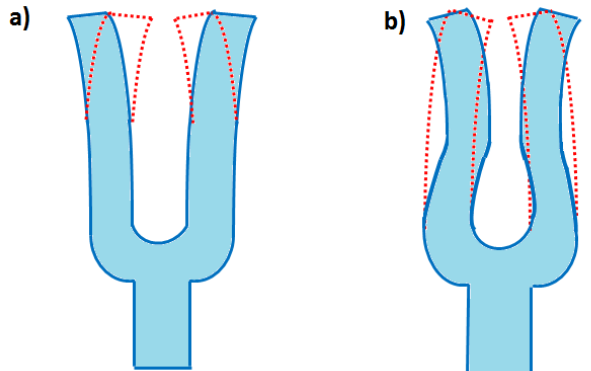
Figure 4. ( a ) First in-plane vibrational mode of a tuning fork. ( b ) Third in-plane vibrational mode of a tuning